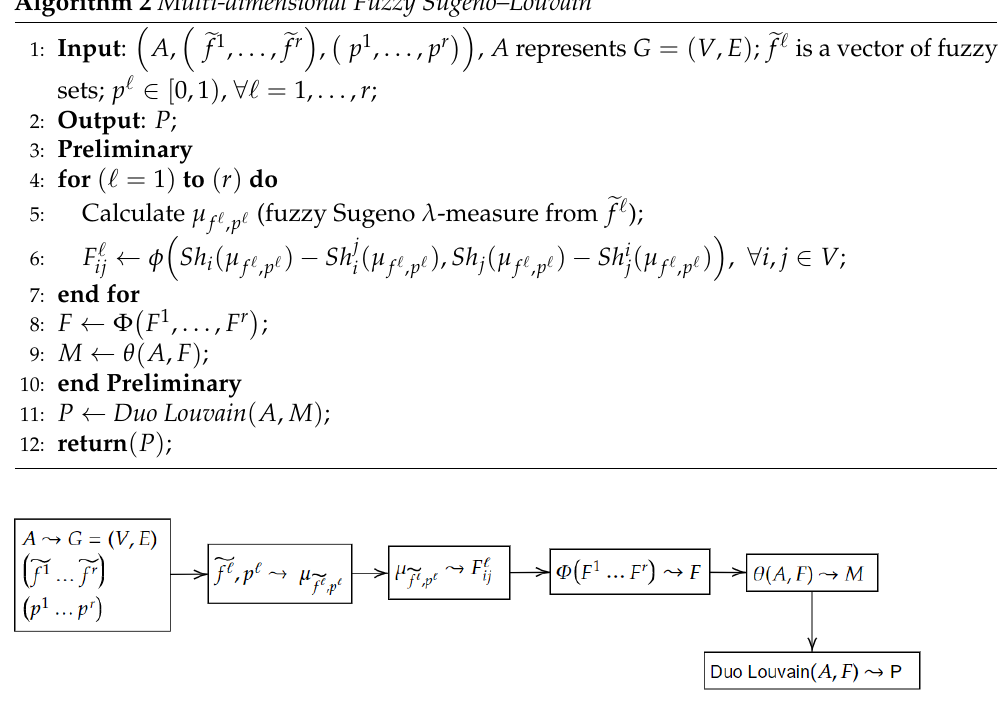
Algorithm 2 Multi-dimensional Fuzzy Sugeno–Louvain